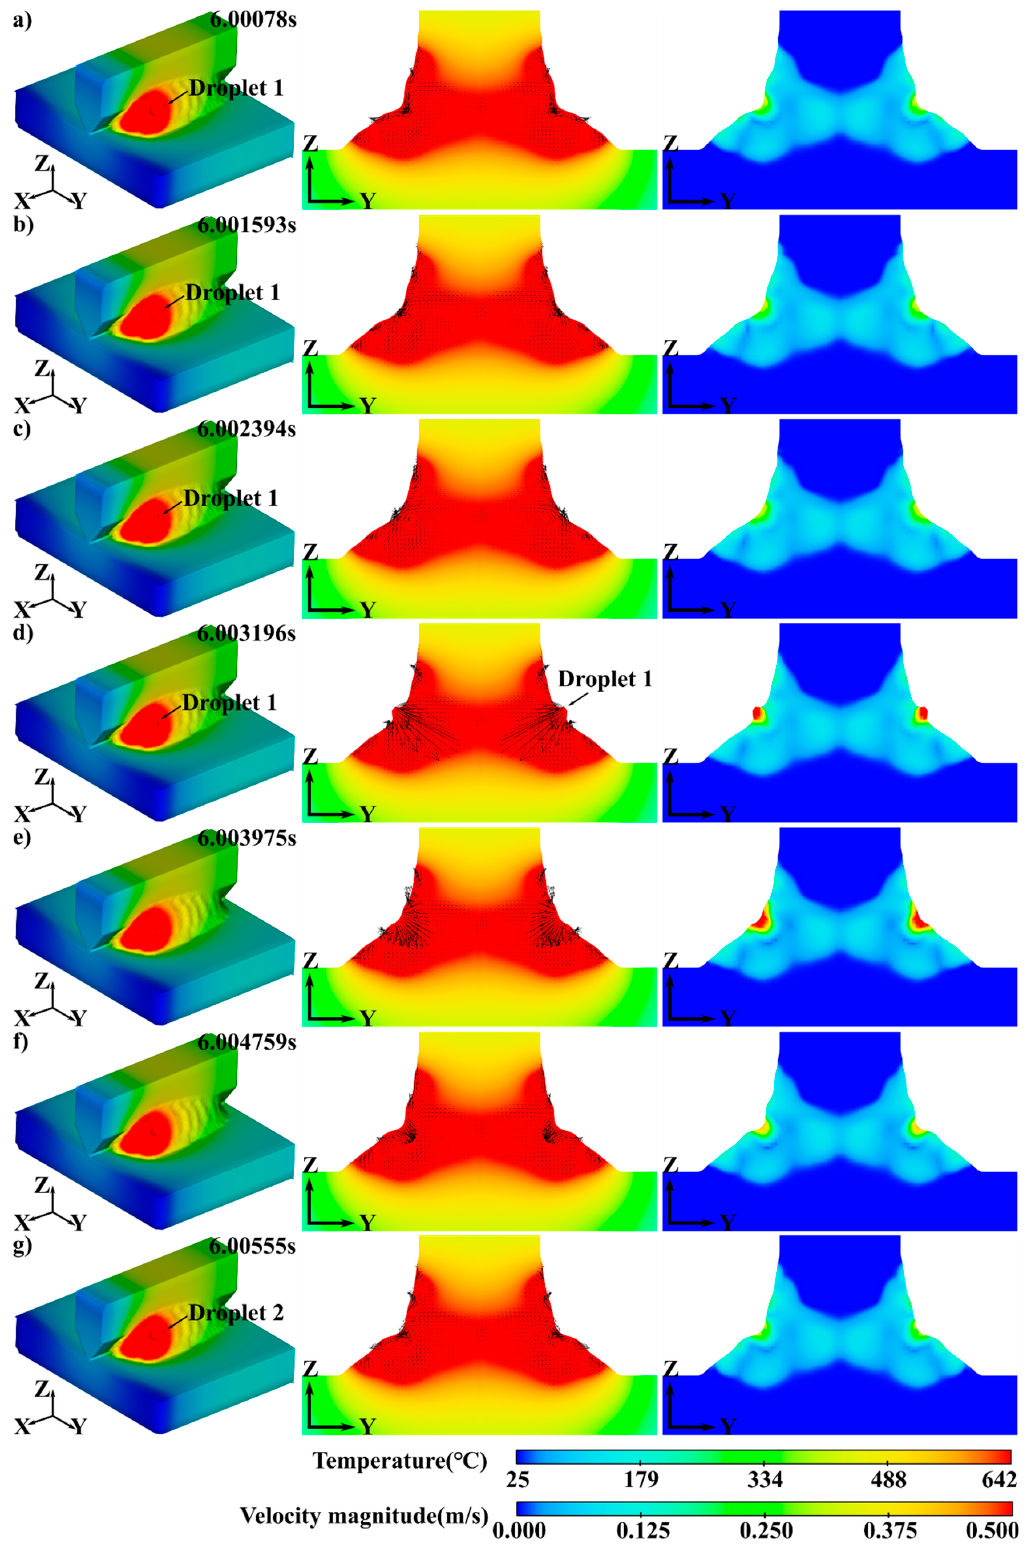
Figure 8. Molten pool behaviors during a single pulse cycle: weld bead appearance (the first column), temperature contours with velocity vectors on the cross sections (the second column), and velocity magnitude distribution on the cross sections (the third column) at ( a ) 6.0078 s, ( b ) 6.001593 s, ( c ) 6.002394 s, ( d ) 6.003196 s, ( e ) 6.003975 s, ( f ) 6.004759 s, and ( g ) 6.00555